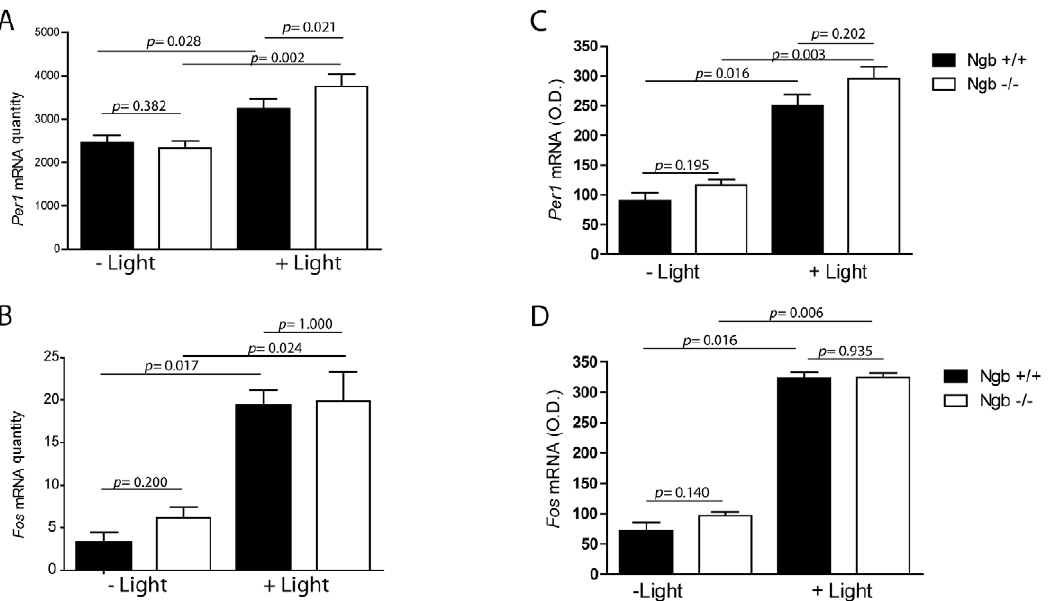
Figure 4. Light induced expression of Per1 (A and C) and cFos (B and D) mRNA in Ngb deficient mice during early night. Left panels (A–B) show the results of quantitative analysis using RT-PCR on SCN tissue ((mRNA/ß2MG mRNA (arbitrary units), see material and methods) and the results in the right panel (C and D) are obtained by semi-quantitative in situ hybridization (optical density, see material and methods). A – B . A 30 min light pulse induced Per1 expression in Ngb deficient mice compared to wild type controls which is significant determined by RT-PCR on SCN tissue. Light stimulation significantly induces cFos expression in both genotypes but no difference was found in between the two genotypes ( B and D ). Error bars=S.E.M., Mann Whitney-U test.